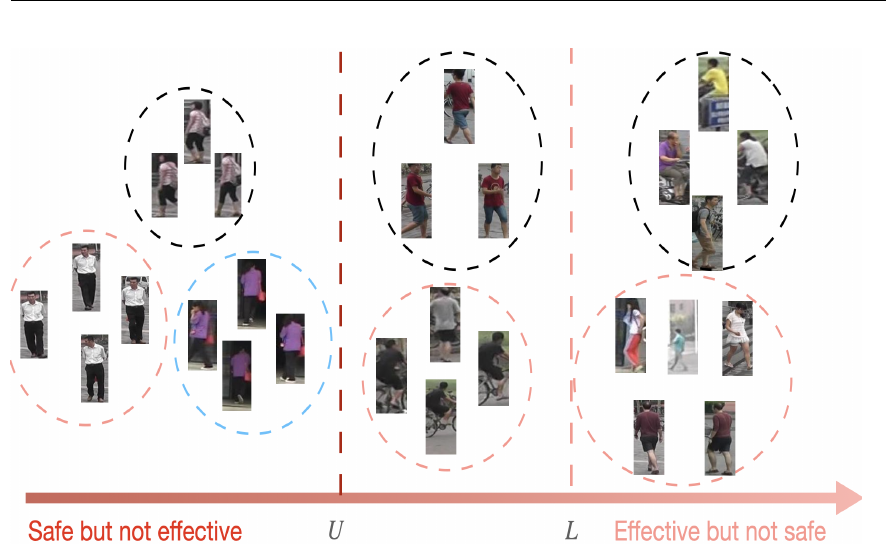
Figure 7. The motivation of dynamic re-weighting. When using a higher threshold to filter the clustering results, the images belonging to the same class are the before and after frames of the same person. These samples are safe but not helpful for cross-camera retrieval. When a lower threshold is used, it can filter positive sample pairs across cameras, but it also introduces noise at the same time. These samples are effective but